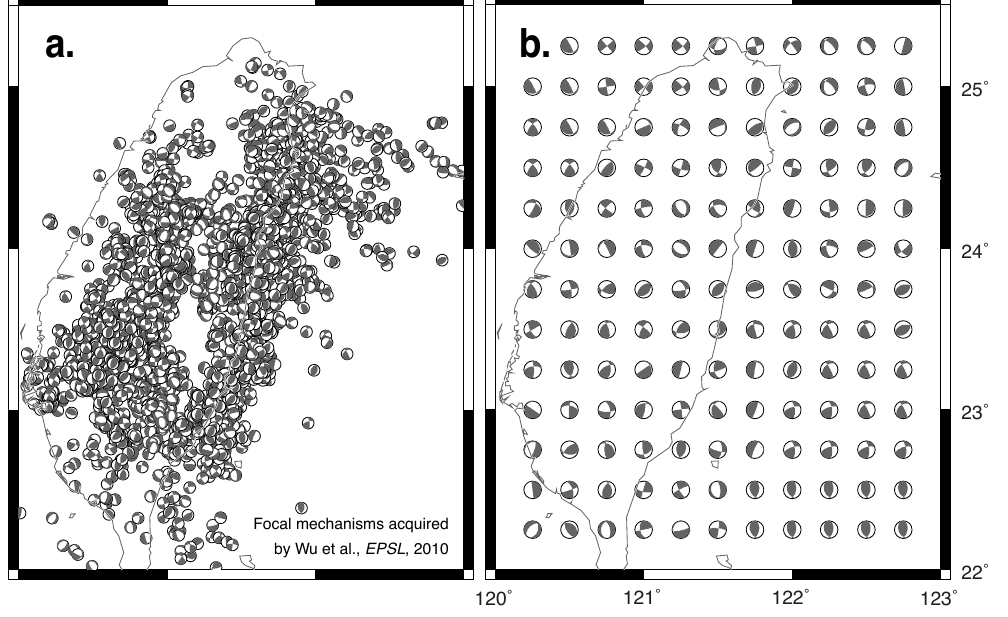
Fig. 2. (a) The reference focal mechanisms collected by Wu et al. (2010). (b) The focal mechanisms as spatial variable receiver faults for the 1 CFS calculation. Note that the actual calculation grids are denser than the spacing presented in the